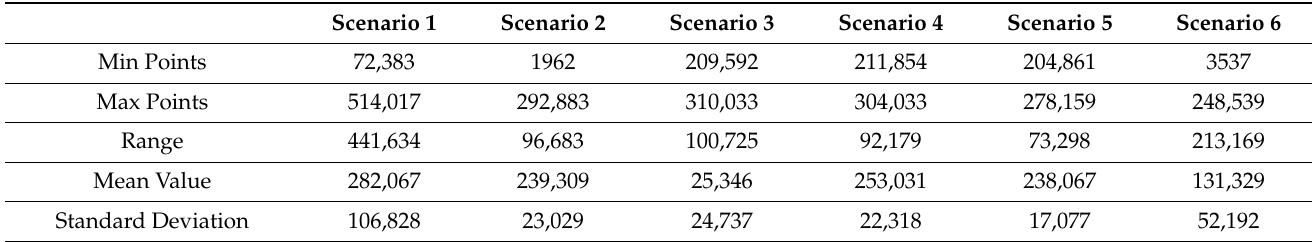
Table 2. Typical scenarios’